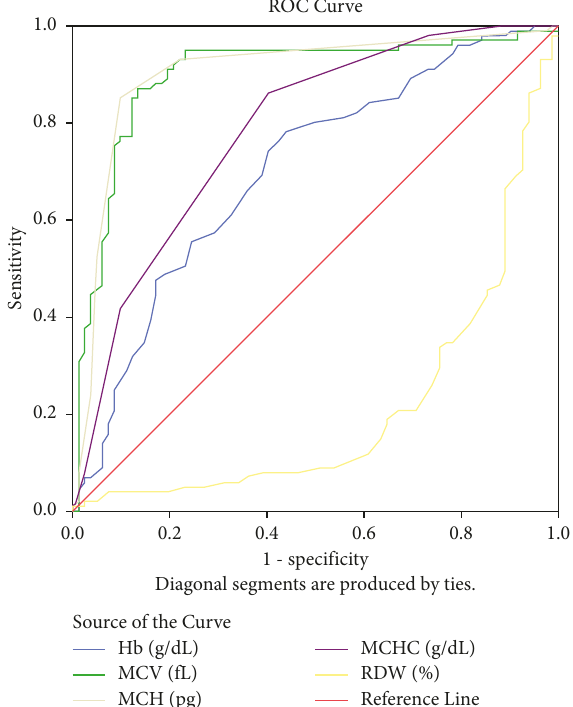
Figure 1: Receiver operative characteristic curves (ROC) of he- matological parameters (Hb, MCV, MCH, MCHC, and RDW) ( P